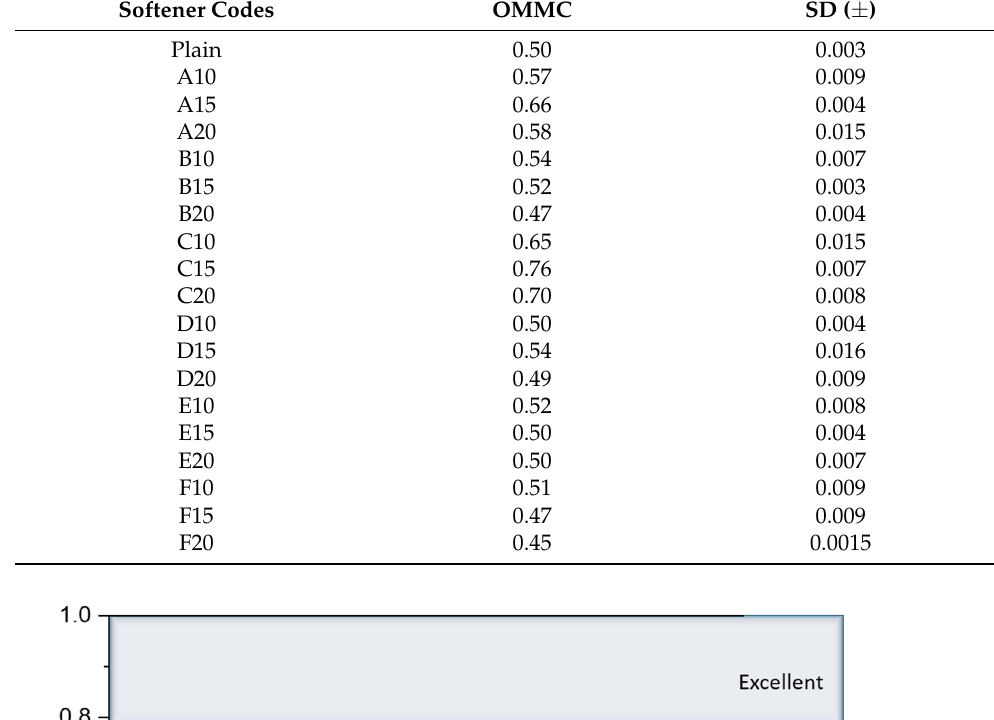
Table 2. OMMC Values of softeners applications against different concentrations.